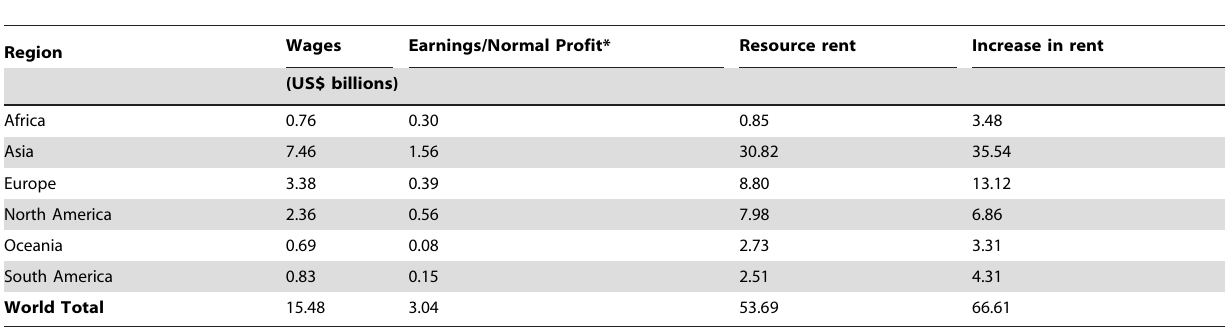
Table 3. Wages, normal profit, resource rent and increase in rent from rebuilt fisheries.